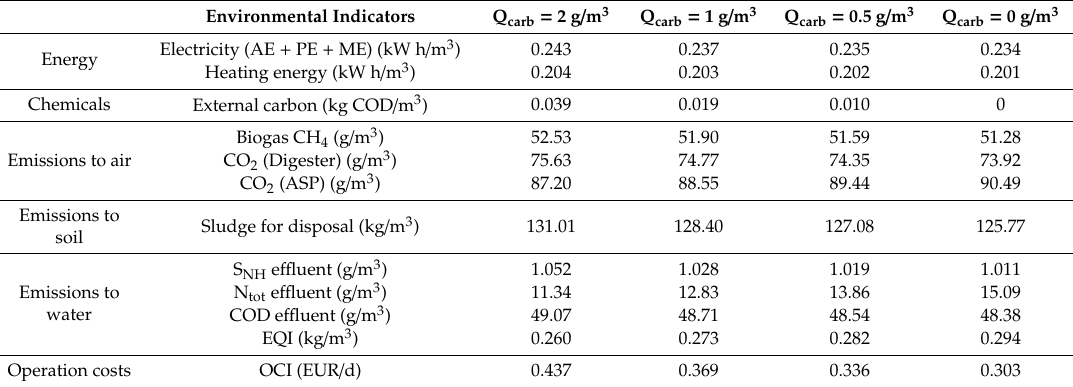
Table 9. Annual values of environmental indicators and operating costs of the BSM2 plant with respect to the volume of treated wastewater using the ammonium-based control scheme (Cascade S NHSP ) with S NHSP = 1 g / m 3 and di ff erent values of Q carb